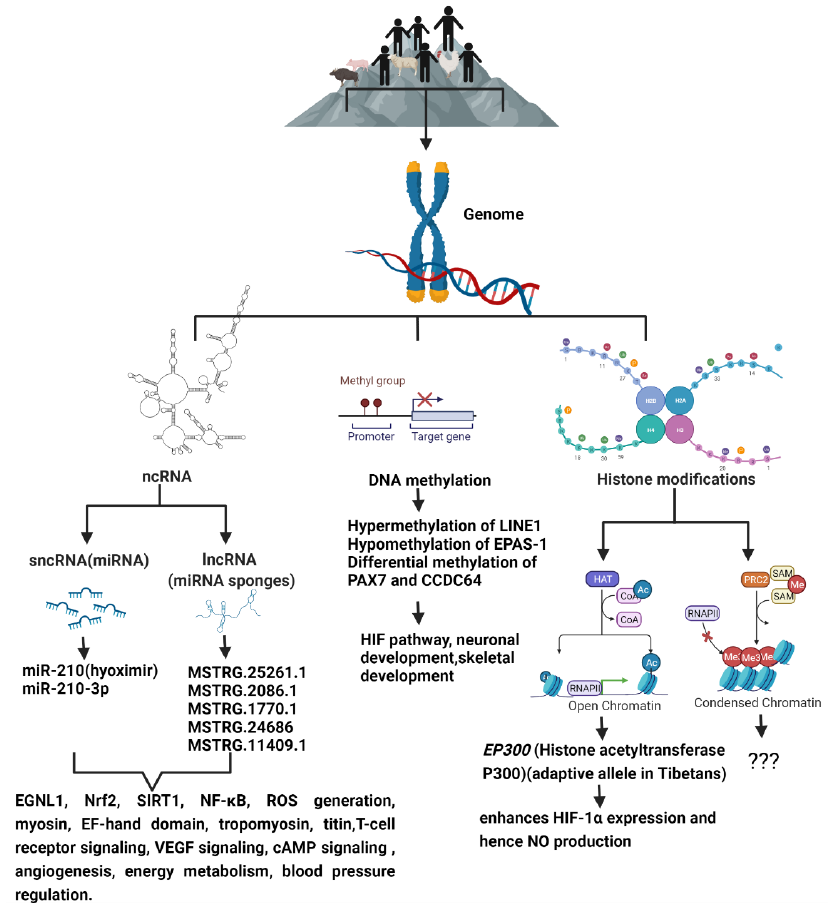
Figure 1. The schematic diagram shows the epigenetic modifications predominant in high-altitude living organisms when compared to their lowland counterparts, and the genes and signaling pathways that are altered as a result of high-altitude living.